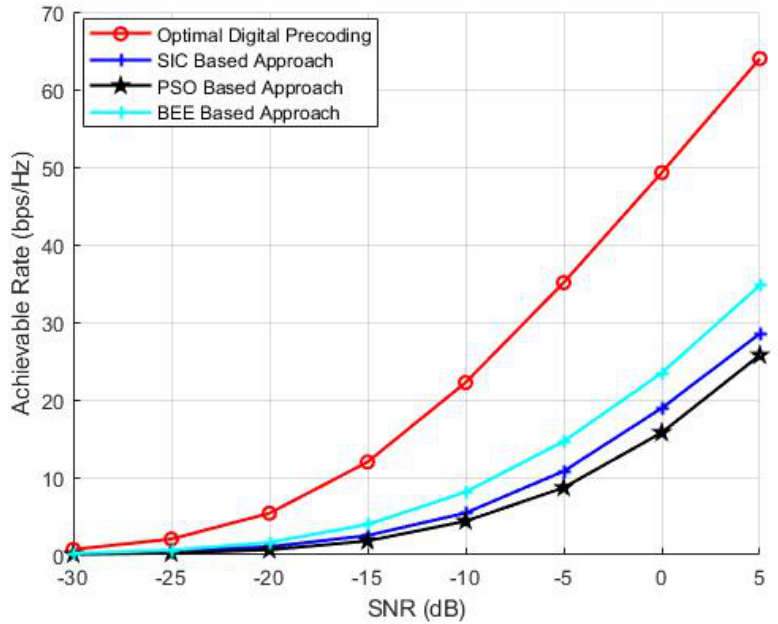
Figure 8. Simulations using N T = 144, N R = 36, N rf = 9.